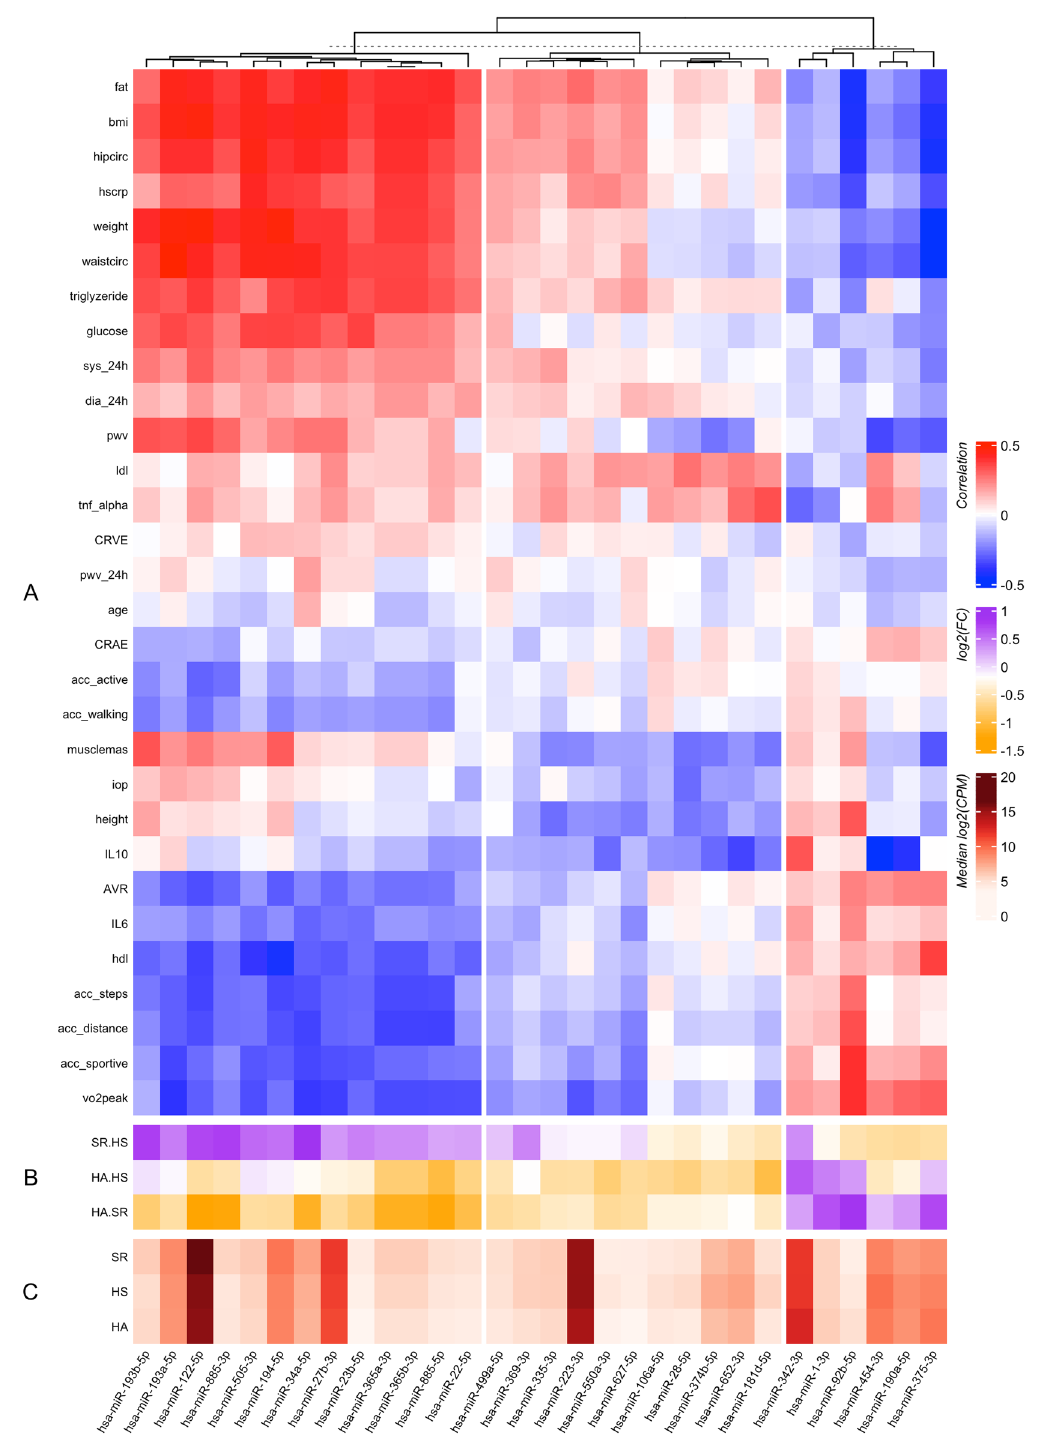
Figure 3. Relationship between miRNA expression levels and values of various physiological parameters. ( A ) Correlation coefficients have been calculated between the miRNA expression levels and the values of the indicated physiological parameters. ( B ) Fold-changes of the corresponding miRNAs among the indicated pairs of samples. ( C ) Median expression level of these miRNAs across samples (in counts per million, CPM). Fat fat mass, BMI body mass index, hipcirc hip circumference, hscrp high sensitive C-reactive protein, waistcirc waist circumference, sys_24h systolic blood pressure based on 24 h monitoring, dia_24h diastolic blood pressure based on 24 h monitoring, pwv pulse wave velocity, ldl low-density lipoprotein, tnf_alpha tumor necrosis factor alpha, CRVE central retinal venular equivalent, pwv_24h pulse wave velocity based on 24 h monitoring, CRAE central retinal arteriolar equivalent, ACC accelerometer, active activity counts, iop intraocular pressure, IL interleukin, AVR arteriolar-to-venular diameter ratio, hdl high- density lipoprotein, VO2peak peak oxygen uptake, HA healthy active individuals, HS healthy sedentary individuals, SR sedentary individuals with at least 2 cardiovascular risk